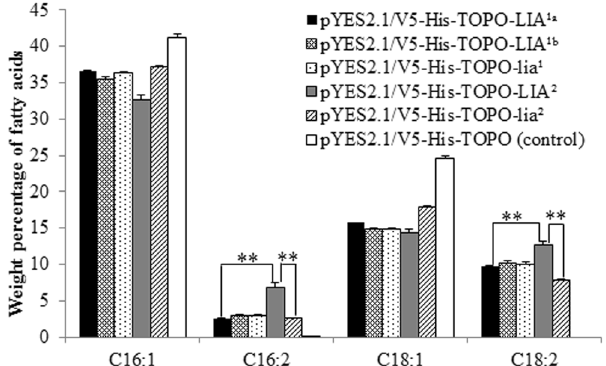
Figure 3. Heterologous expression of the SalFAD2 . LIA 1 alleles LIA 1a , LIA 1b and lia 1 , and SalFAD 2. LIA 2 alleles LIA 2 and lia 2 in Yeast. Gas chromatography analysis of fatty acid composition of yeast cells containing the construct pYES2.1/V5-His-TOPO-LIA 1a with LIA 1 a coding DNA sequence (CDS), pYES2.1/V5-His-TOPO- LIA 1b with LIA 1b CDS, pYES2.1/V5-His-TOPO-lia 1 with lia 1 CDS, pYES2.1/V5-His-TOPO-LIA 2 with LIA 2 CDS, pYES2.1/V5-His-TOPO- lia 2 with lia 2 CDS and the empty vector pYES2.1/V5-His-TOPO. ** Statistical significant difference at p = 0.01